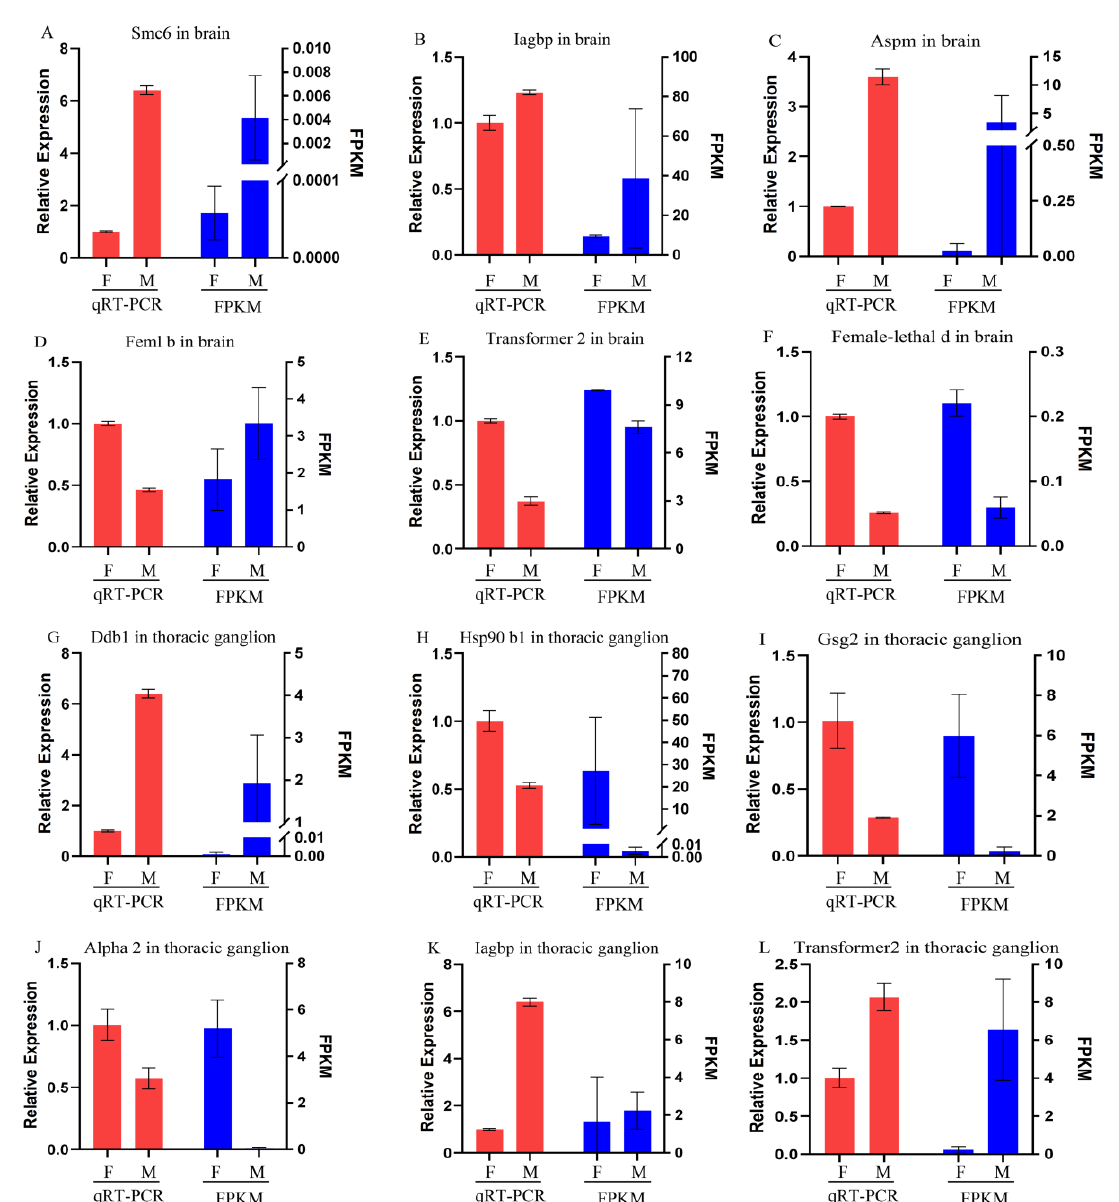
Figure 6. Validation of ten DEG profiles by qRT-PCR. F: female prawn, M: male prawn. The FPKM (Fragments per kilobase of transcript per million mapped reads) value was calculated by eXpress. The abbreviated genes, Smc6: Structural maintenance of chromosomes protein 6-like; Iagbp: Insulin-like androgenic gland hormone binding protein; Aspm: Abnormal spindle-like microcephaly-associated protein homolog; Ddb1: DNA damage-binding protein 1; Hsp90b1: Heat shock protein 90 beta 1; Gsg2: Ganglioside GM2